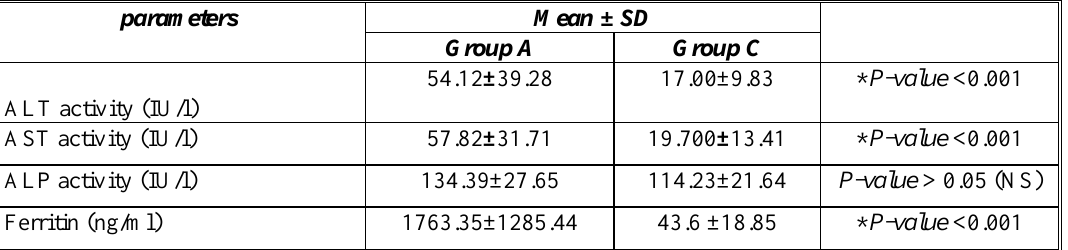
Table1. Differences in Serum ALT, AST, ALP and Ferritin between Group A and C.